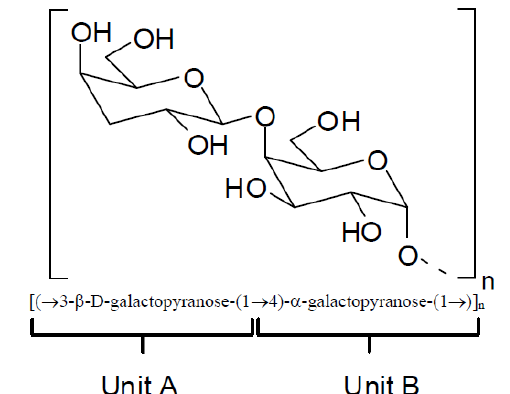
Figure 2. Repeating basic structure of galactans.